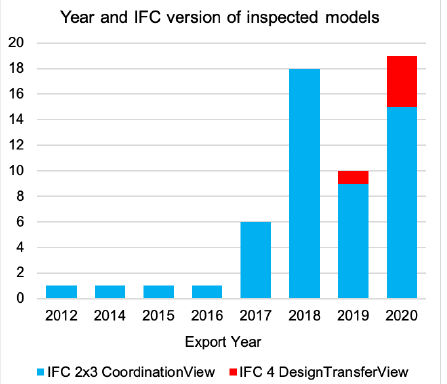
Figure 2. Distribution of the sample models per year and Industry Foundation Classes (IFC)